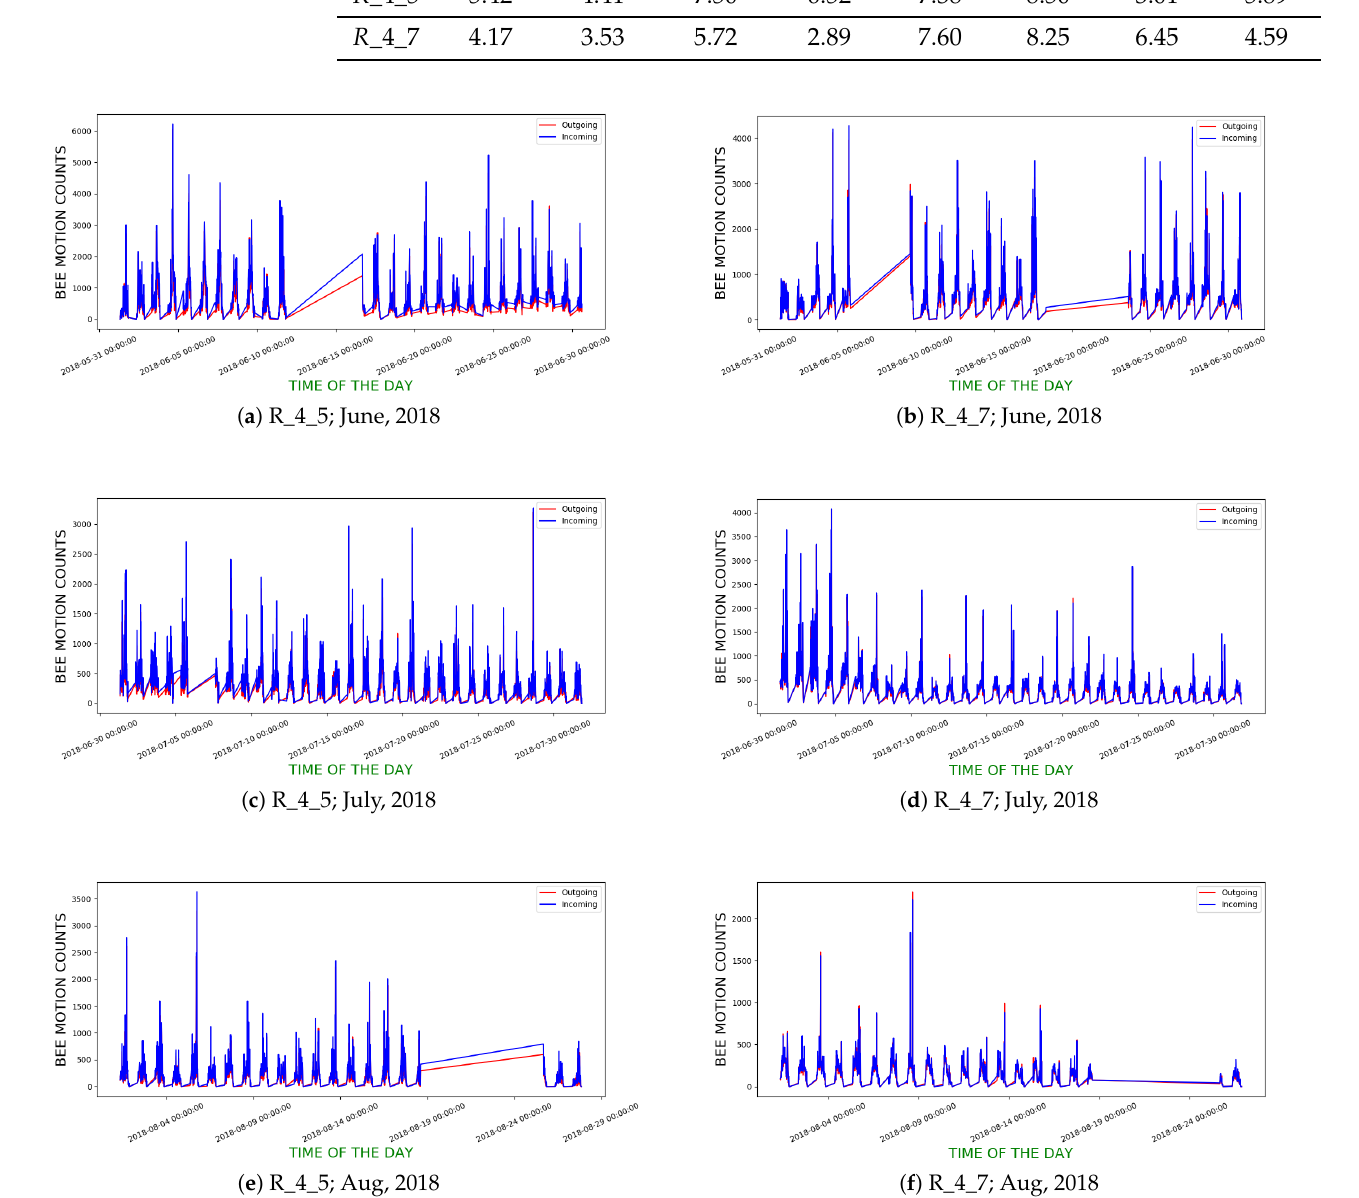
Figure 19. Hourly incoming and outgoing bee motion curves of R_4_5 and R_4_7 in June, July and August 2018; straight line segments in curves indicate lack of data on corresponding periods due to hardware